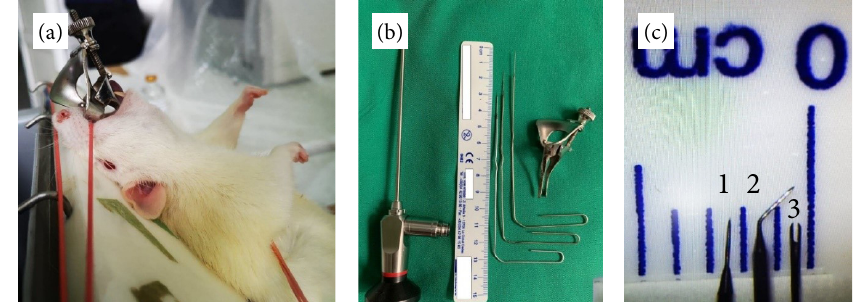
Figure 1 - Rat positioning, equipment, and setup. (a) Custom-made operating platform, with the rat positioned semi vertically and secured with three rubber bands at the level of the rare, front limbs and incisive teeth. (b) Equipment consisting of 2.7 mm-diameter 30° endoscope, custom electron microscopy instruments for lesion induction and a repurposed Voltolini self-retractor nasal speculum. The speculum blade margins were narrowed and straightened so that they fit through the rat’s mouth to aid in the pharyngeal lumen patency. (c) Close up view of the instruments used for vocal